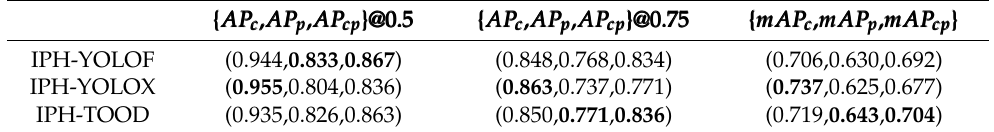
Table 3. Illustration of the AP p difference between the three baseline detectors we proposed, i.e., IPH-YOLOF, IPH-YOLOX, and IPH-TOOD, on the IPHPDT dataset. Note that AP c , AP p , and AP cp represent the precision metric for the prediction of the human category, human posture, and the composite of both, respectively.